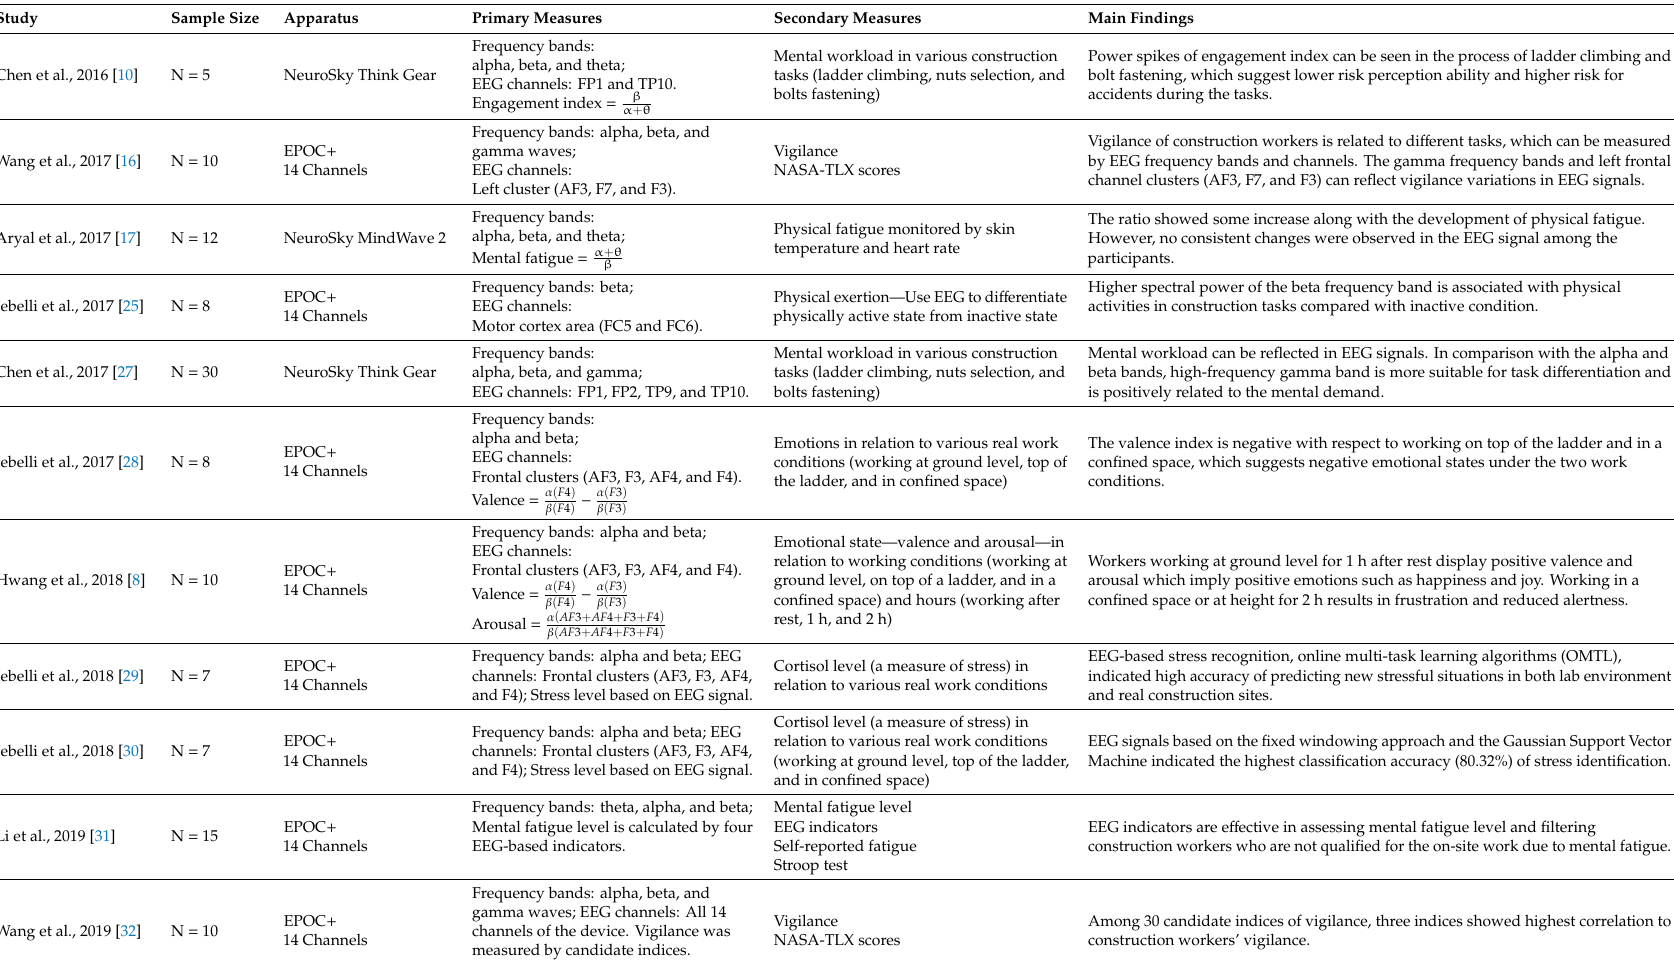
Table 1. Summary of study